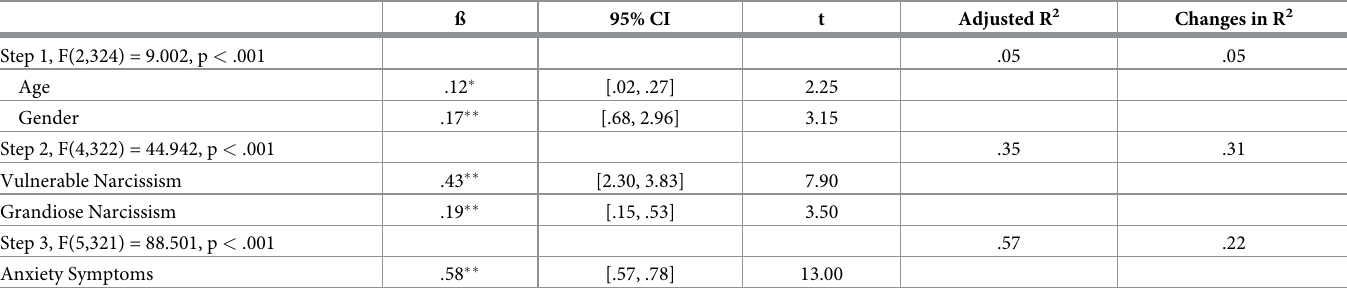
Table 2. Hierarchical regression analysis with Facebook Addiction as outcome, vulnerable narcissism, grandiose narcissism and anxiety symptoms as predictors; controlling for age and gender. ß